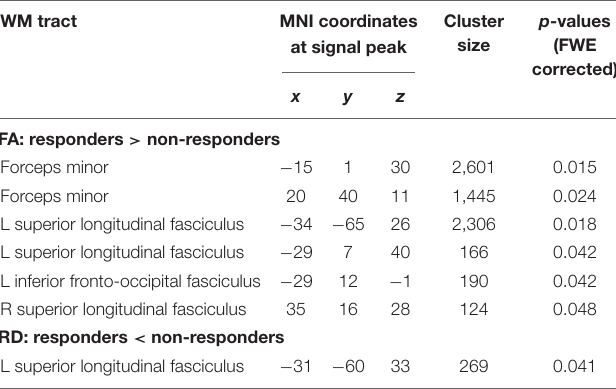
TABLE 3 | White matter tracts with significant differences in FA and RD between future responders and non-responders to paroxetine treatment after controlling for age, sex, and time between